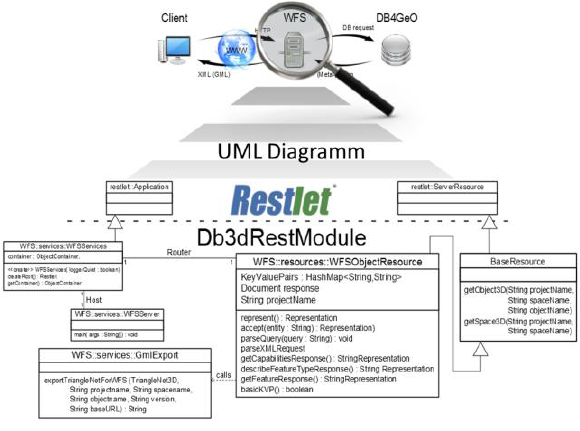
Figure 2: UML-Diagram of DB4GeO´s